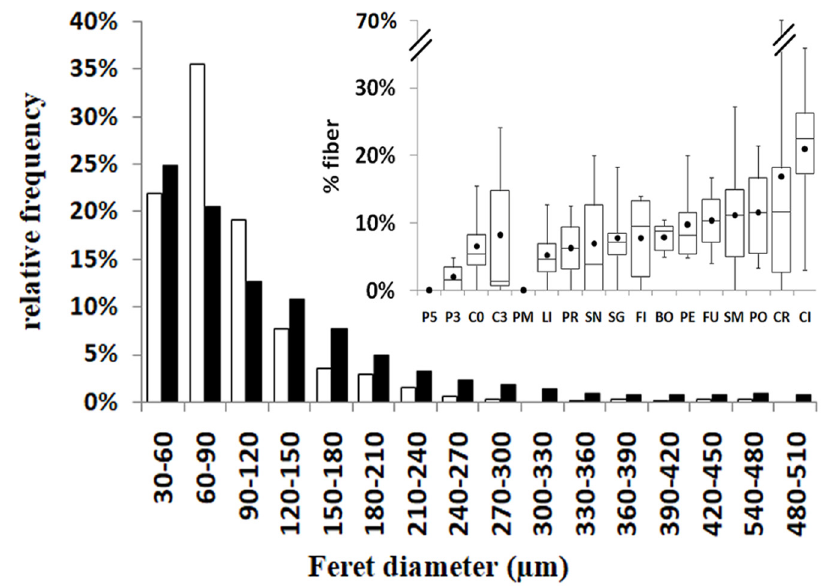
Figure 1. Histograms of the relative abundance of microplastics for size range measured by Feret diameter, from Venice lagoon (grey), Goro lagoon (white), -inset graph-Boxplot with mean (round circles) of the relative abundance of fibers in different stations from Goro (P5-C3) and Venice (PM- CI) lagoon.